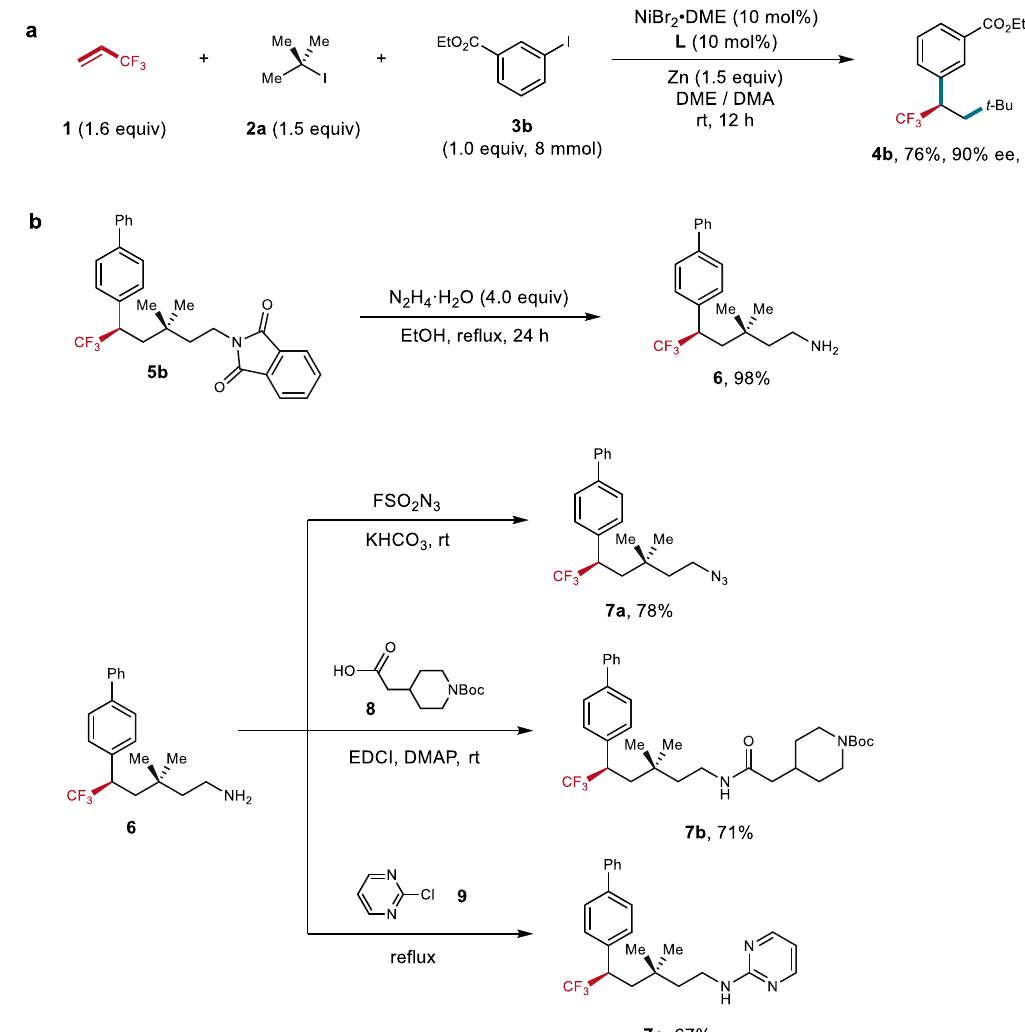
Fig. 3 | Synthetic applications. a Gram-scale synthesis of 4b . b Transformations of compound 5b . EDCI, (1-ethyl-3(3-dimethylpropylamine)